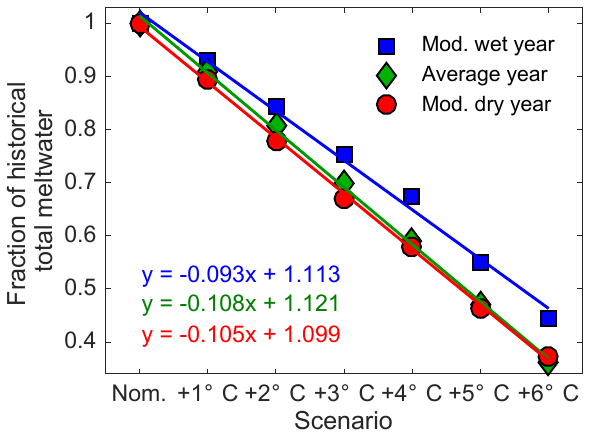
Figure 7. The fraction of simulated domain-wide historical meltwa- ter ( y axis), relative to the nominal case, for each warmer temper- ature scenario ( x axis) for the three years (marker type and color). The colored lines and associated regression equations show linear fits to the data. For each year, the R 2 value was >0.99 and the p value was (cid:28) 1 × 10 − 6